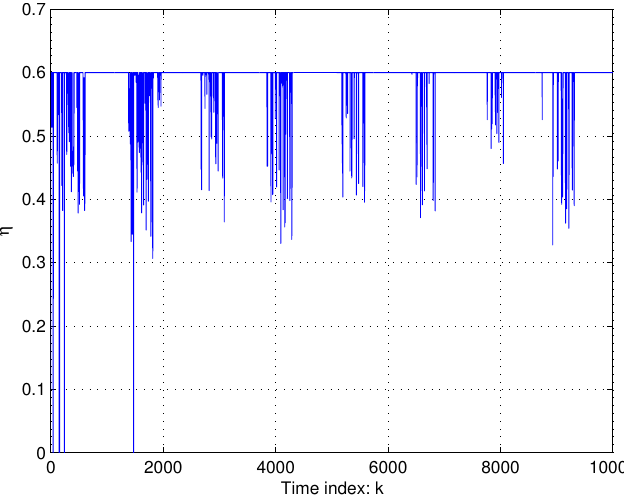
Figure 11. Learning rate of the MiFREN controller: η ( k ) .